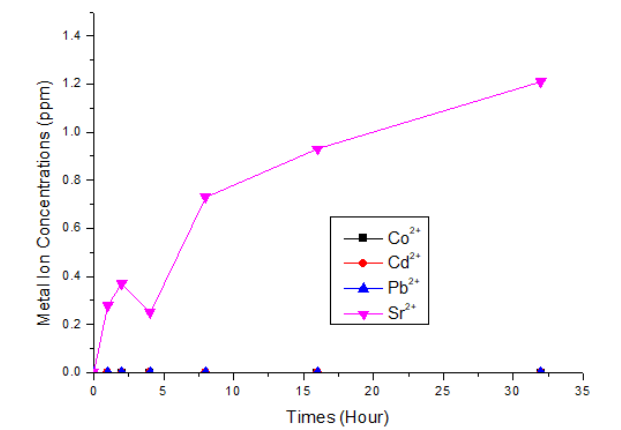
Fig. 8. TCLP result of heavy